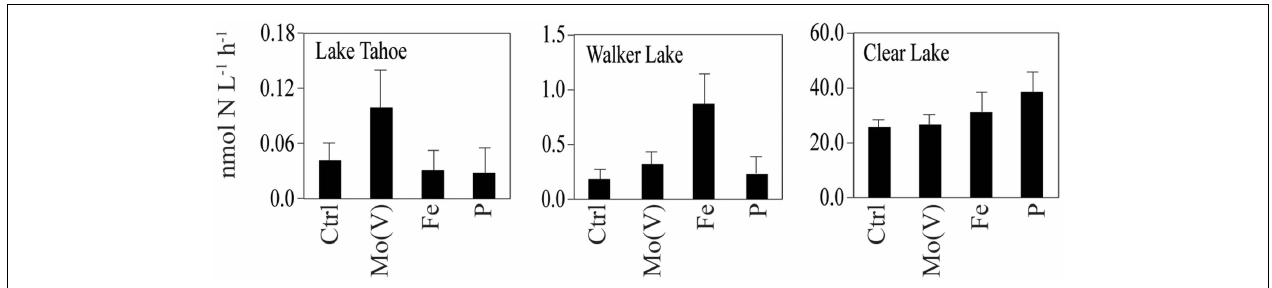
FIGURE 3 | N 2 fixation measured in different lakes under different nutrient enrichment conditions [Ctrl, Mo(V), Fe, P] during the sampling campaigns of 2009 and 2010. Water for incubation experiments was taken from a depth of 0.5m. Data shown as arithmetic mean ± SE ( N =